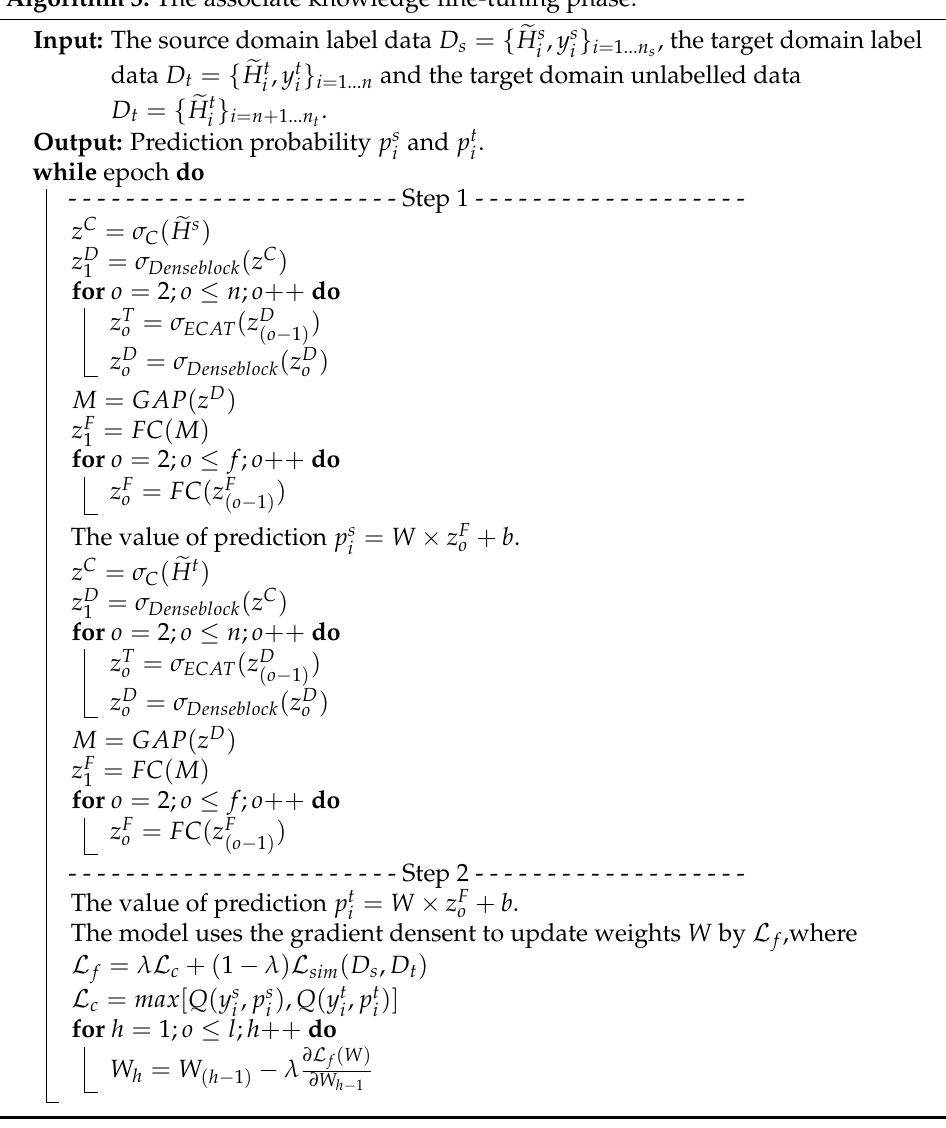
Algorithm 3: The associate knowledge fine-tuning